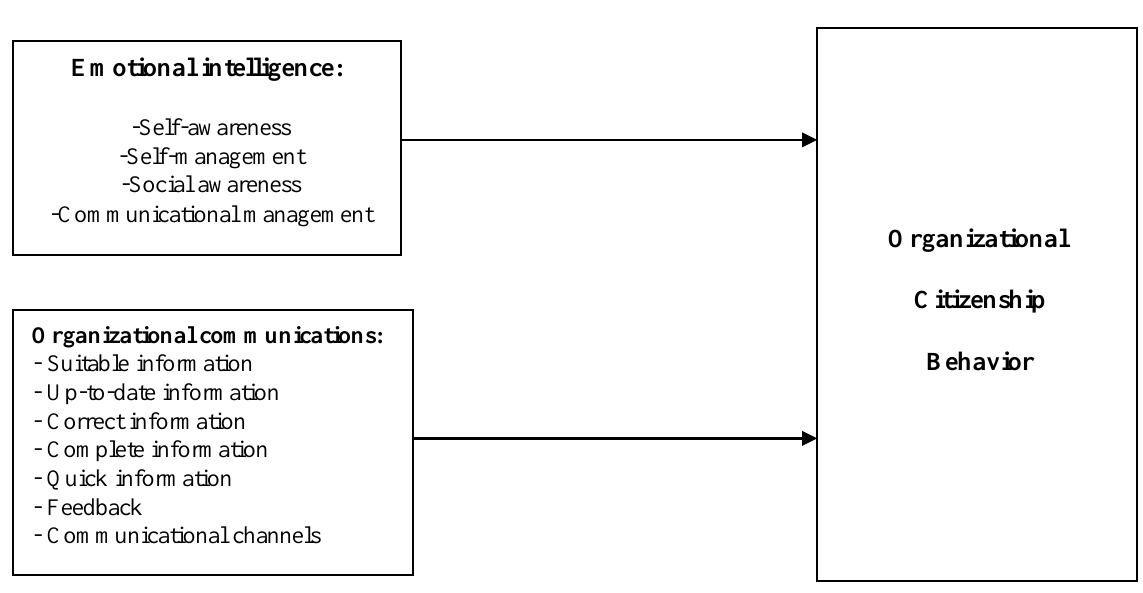
Fig. 1. The proposed